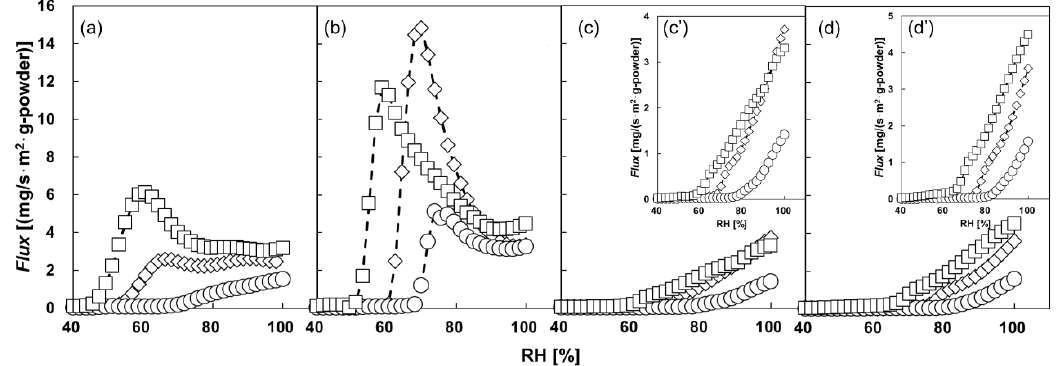
Figure 3. Release profile of d -limonene under linearly ramped humidity. ( a ): Suc, ( b ): Lac, ( c and c ’): MD (DE = 25), ( d and d ’): MD (DE = 19). ○ : 40 °C, ◇ : 50 °C, and □ : 60 °C.